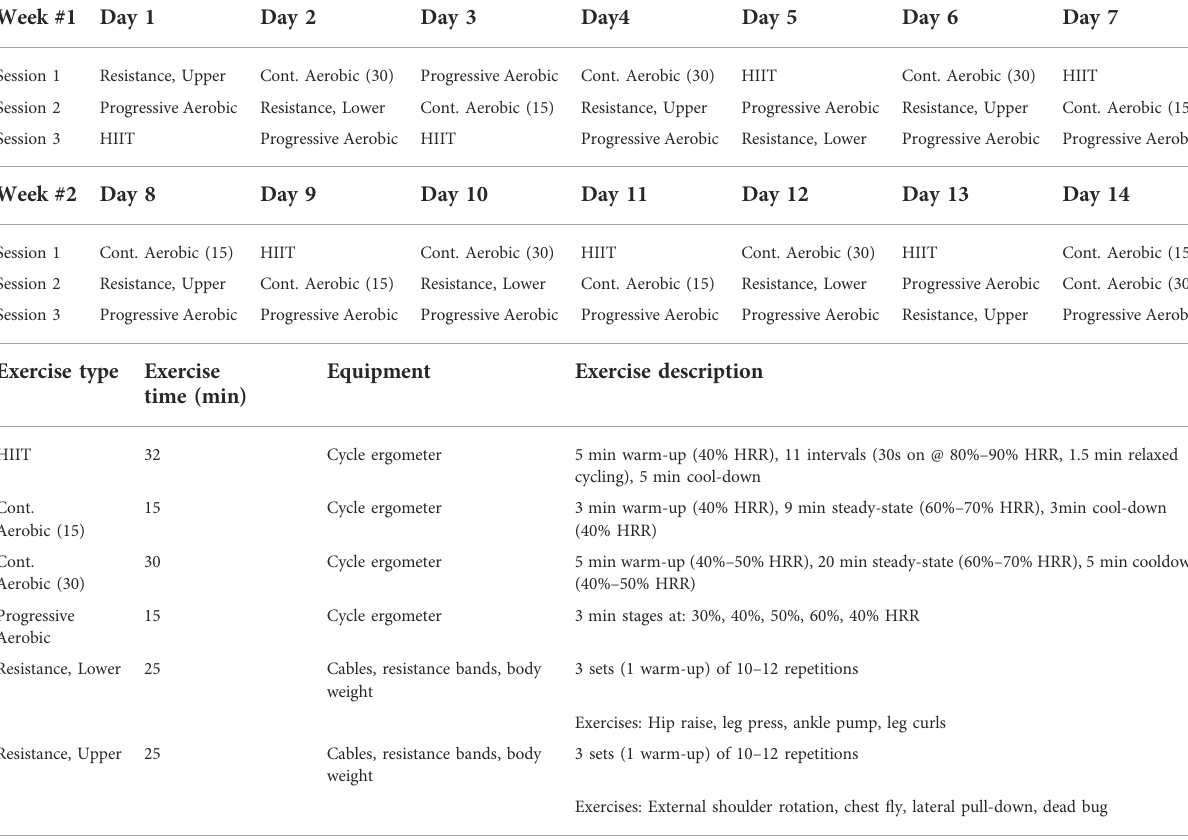
Resistance, Upper 25 Cables, resistance bands, body HRR, heart rate